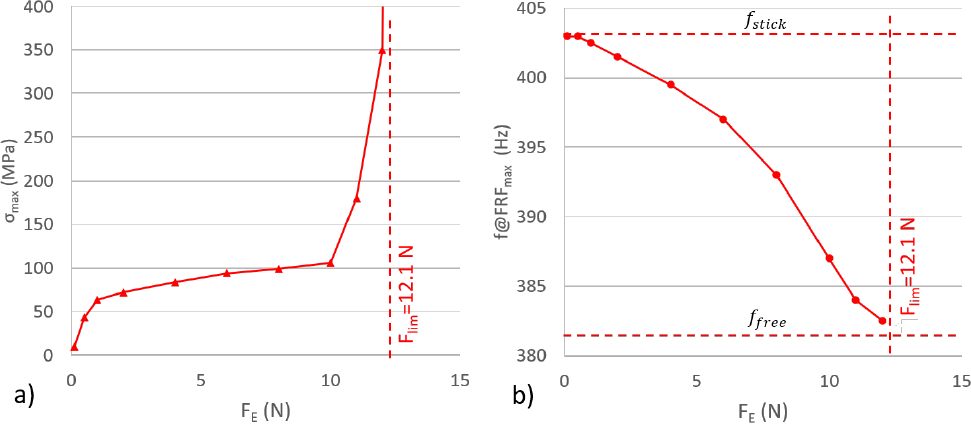
Figure 5. ( a ) Maximum bending stress on the blade (at airfoil root) as a function of F E , same case as Figure 4 for extended | F E | range; ( b ) resonance frequency as a function of F E